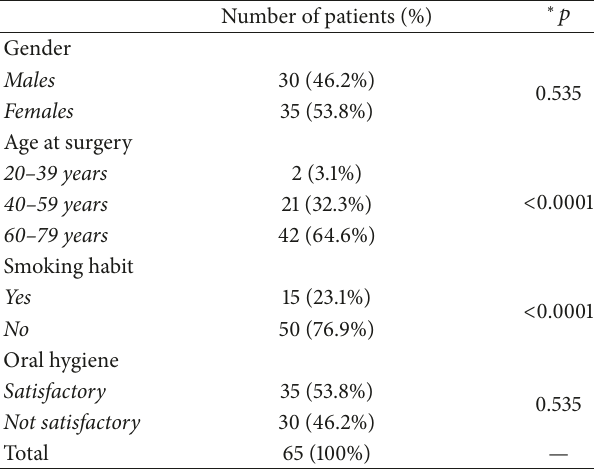
Table 1: Patient